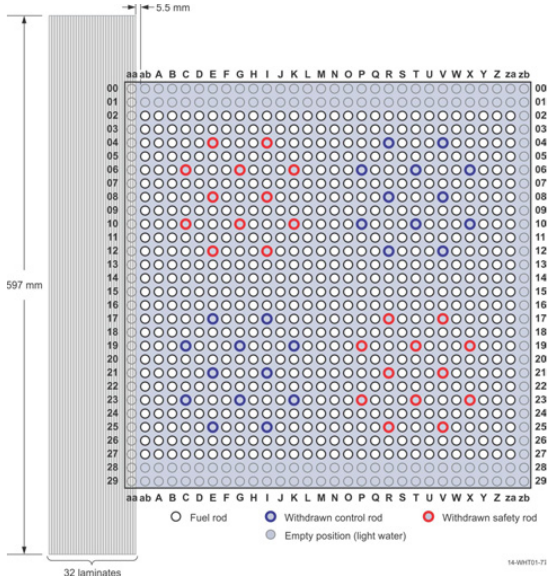
Figure 5. IPEN/MB-01 reactor with 32 nickel plates.